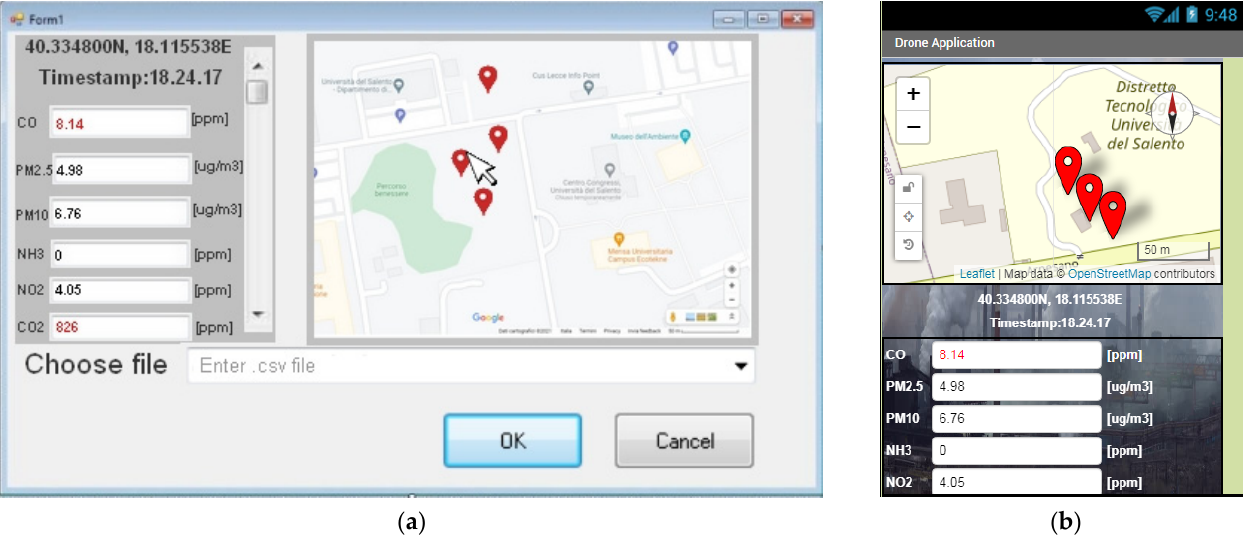
Figure 10. Screenshots of the local application used to upload the drone’s data on cloud platform ( a ) and mobile application for monitoring the measurements acquired by drone ( b ).